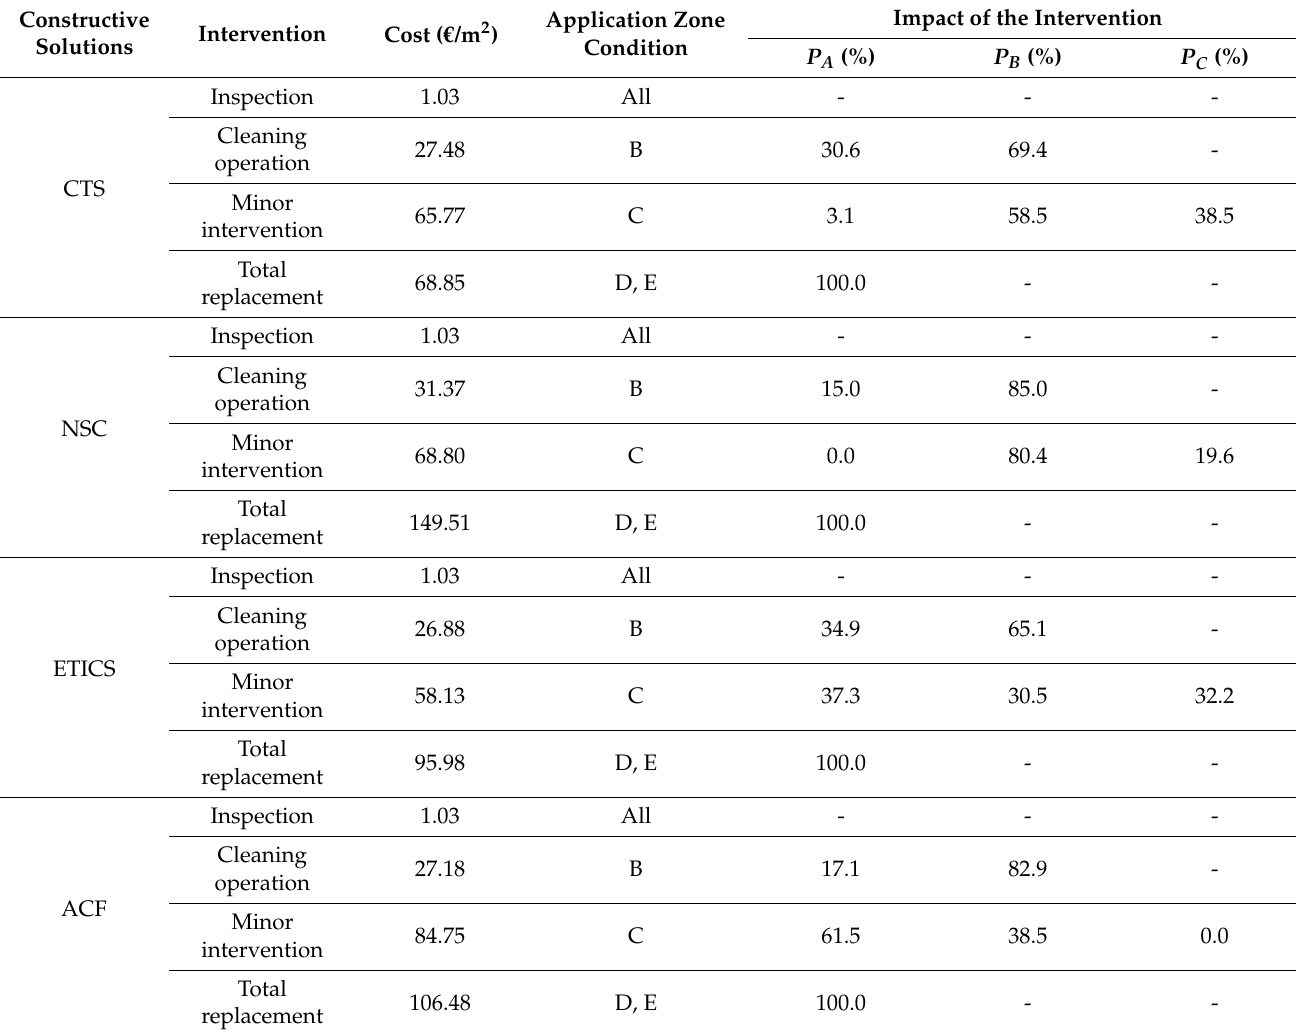
Table 2. Costs, application zones, and impacts of the different types of interventions analyzed for the four constructive solutions. Constructive